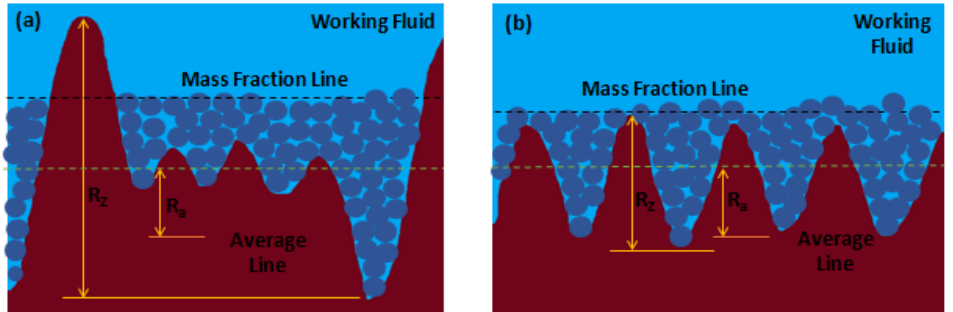
Figure 5. Schematic illustration of the boiling nanoparticle deposition on two different rough sur- faces: ( a ) R a and R z with very different values and ( b ) R a and R z with approximate values.